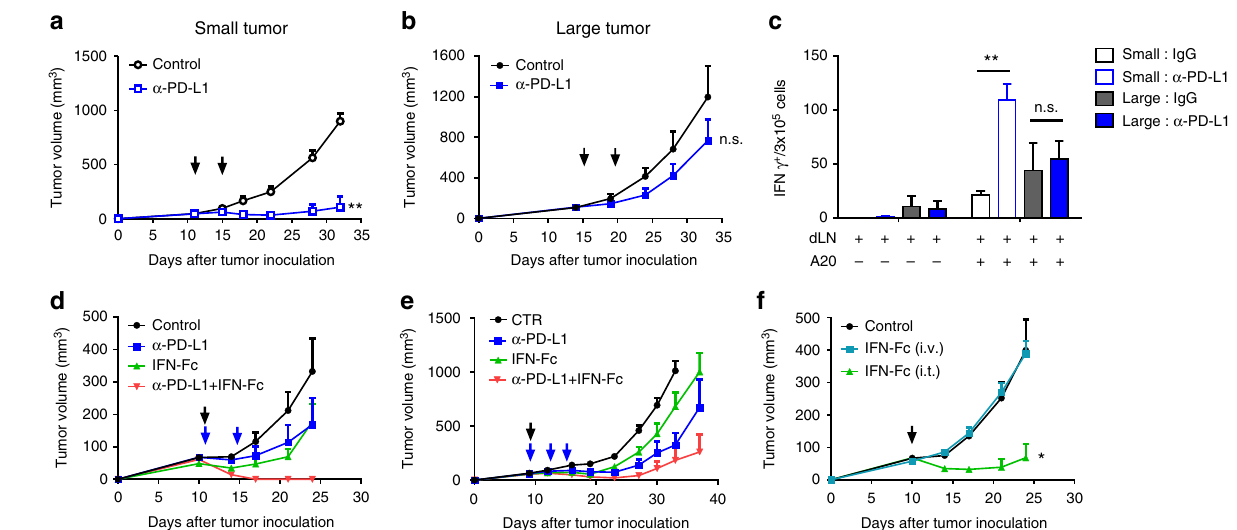
Fig. 1 Local delivery of IFN α overcomes resistance to PD-L1 blockade in advanced tumors. a Balb/c mice ( n = 3) were inoculated with 3 × 10 6 A20 cells. Mice bearing early-stage tumors ( < 50 mm 3 ) were treated intraperitoneally (i.p.) with 200 µ g of anti-PD-L1 on days 11 and 15. b Mice ( n = 4) bearing advanced A20 tumors ( > 100 mm 3 ) were treated with anti-PD-L1 on days 15 and 19. Tumor growth was measured twice per week. c Mice were treated as in a and b . Three days after treatment, cells from draining lymph nodes were isolated and co-cultured with or without irradiated A20 cells for 2 days. The IFN γ ELISPOT assay was performed. d A20 tumor-bearing mice ( n = 5) were treated with 200 µ g of anti-PD-L1 i.p. on days 11 and 15 and/or 25 µ g IFN α -Fc intratumorally (i.t.) on day 11. e C57BL/6 mice ( n = 5) were inoculated with 5 × 10 5 MC38 cells. Mice were treated with 200 µ g of anti-PD-L1 i.p. on days 9, 12, and 15, and/or 25 µ g of IFN α -Fc i.t. on day 9. The growth curves of MC38 tumors are shown. f A20 tumor-bearing mice ( n = 5) were treated i.t. or intravenously (i.v.) with 25 µ g of IFN α -Fc on day 11. Black and blue arrows indicate treatment with IFN α -Fc and anti-PD-L1, respectively. Data indicate mean ± SEM and are representative of at least two independent experiments. * p < 0.05; ** p < 0.01; n.s. not signi fi cant homodimer have K D values in the nM range (2 nM or 0.2 nM) (Supplementary Fig. 3c). The type I IFN bioactivity in the fusion proteins was identi fi ed through anti-viral infection biological assay. IFN α -Fc protein could inhibit VSV-GFP (vesicular sto- matitis virus expressing green fl uorescent protein) infecting L929 cells in a dose-dependent manner. While at the same ef fi cient concentration, both homodimer and heterodimer protein showed higher inhibition ef fi ciency compared to that of the control IFN α - Fc protein (Fig. 2d). Collectively, these data suggest that both the homodimer and heterodimer formats of IFN α -anti-PD-L1 fusion protein can bind to PD-L1 while maintaining robust IFN α bioactivity.